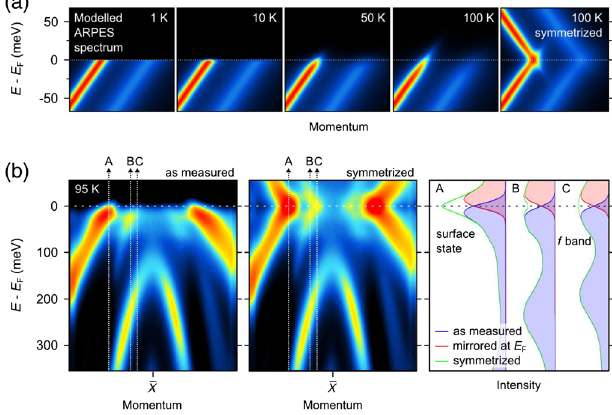
FIG. 4. (a) Thermal broadening due to the Fermi-Dirac sta- tistics smears out the photoemission intensity symmetrically in an energy window 2 k B T around E F , as it is shown for a model spectrum here. This makes it difficult to judge the presence or absence of spectral gaps at the Fermi level. A common way to analyze the spectral weight at E F , which has been developed by the high- T c community, is to symmetrize the ARPES spectra around E F in order to overcome thermal broadening effects. (b) The 95 K ARPES data as measured [cf. Fig. 3(d)] and symmetrized around E F . Following the intensity along the cuts A, B, and C, we see at E F (A) enhanced spectral intensity as expected for the surface state, (B) a spectral gap where no band is crossing E F , and (C) constant intensity at the position of the neck in Fig. 2 confirming that the f band is still crossing E F and that the neck is still open at 95